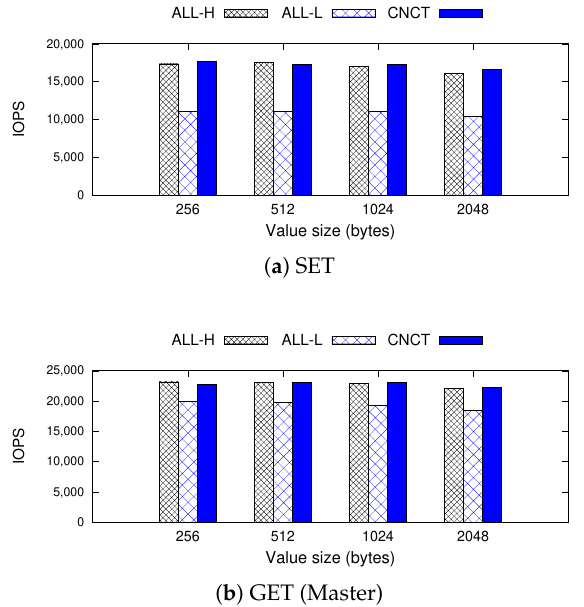
Figure 5. IOPS with Memtier benchmark.